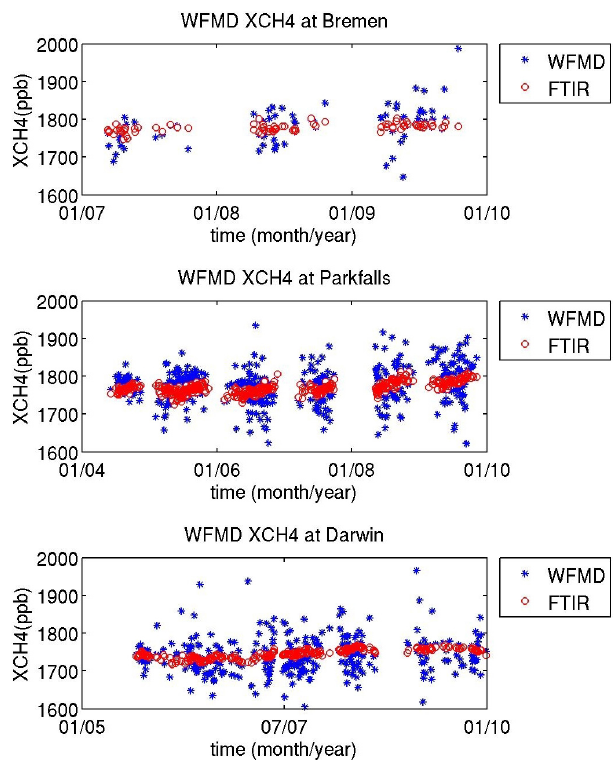
Figure 11. Daily averaged time series of paired WFMD and TC- CON FTIR XCH 4 at Bremen (top), Park Falls (mid) and Darwin (bottom).